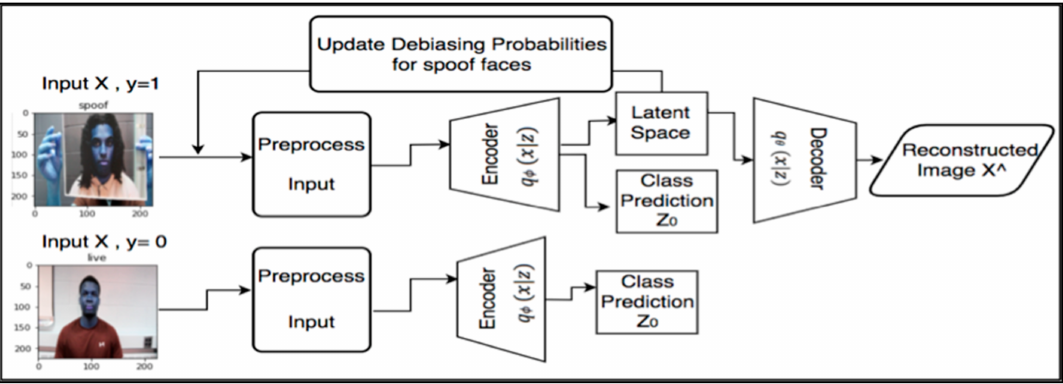
Figure 5. The DE-VAE approach [9].